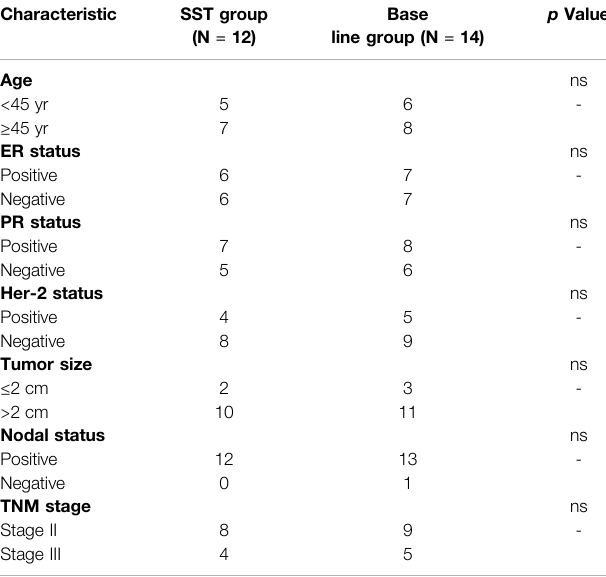
TABLE 1 | Demographic and baseline disease characteristics of the patients.